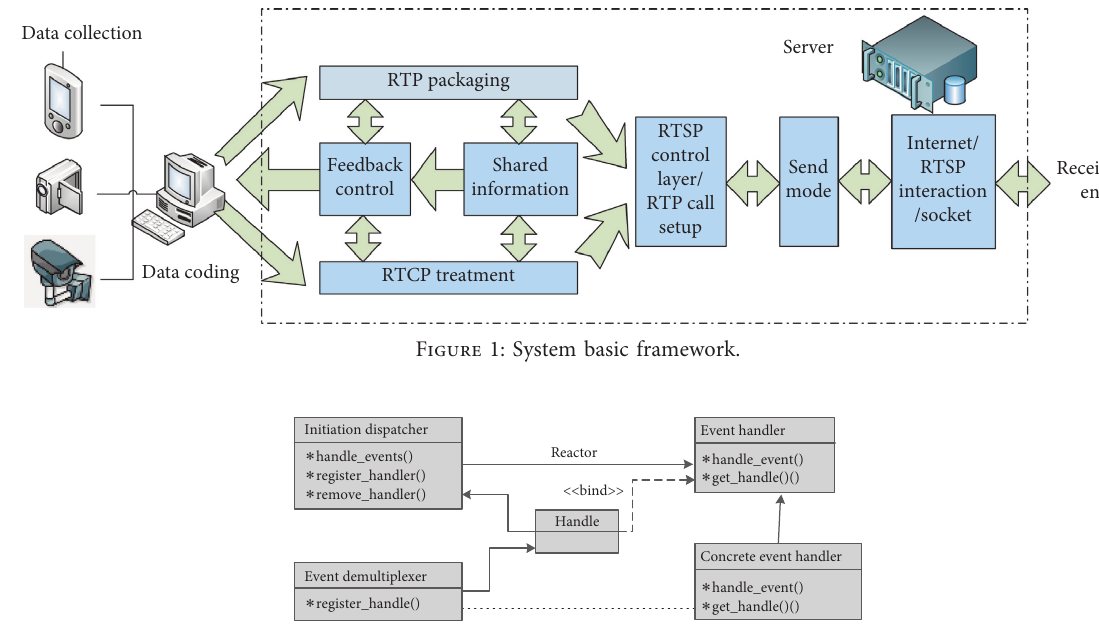
Figure 2: Server core